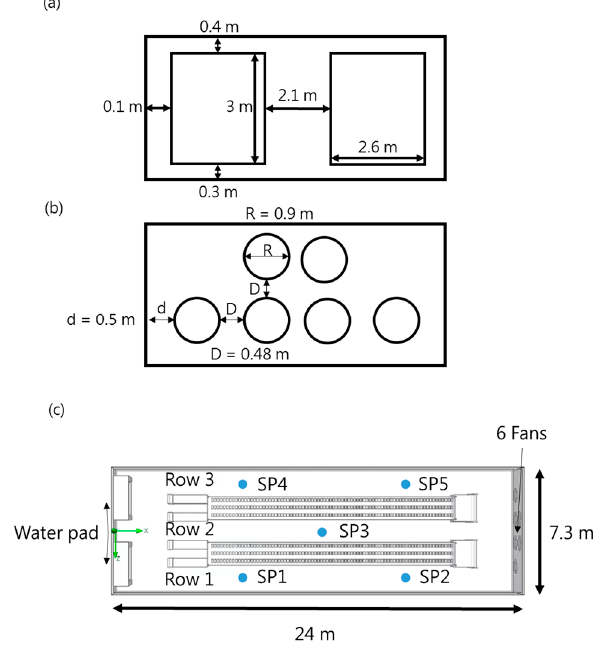
Figure 4. ( a ) Dimensional drawing of the water-pad system; ( b ) Dimensional drawing of the fan; ( c ) Location of measuring points SP1–SP5. ( c ) Location of measuring points SP1–SP5.